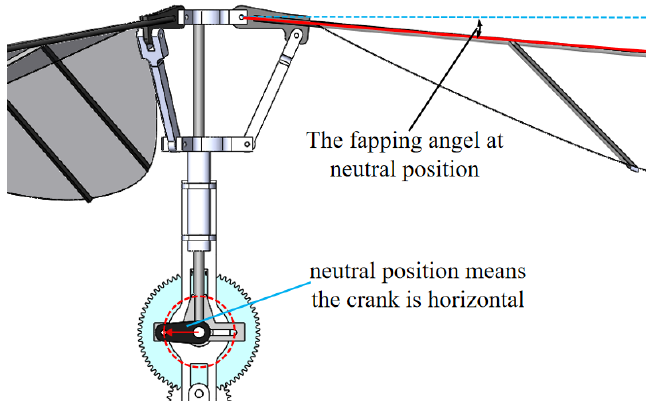
Table 3. The parameters of the FWR with different neutral positions. Figure 17. The wing neutral position of the FWR.